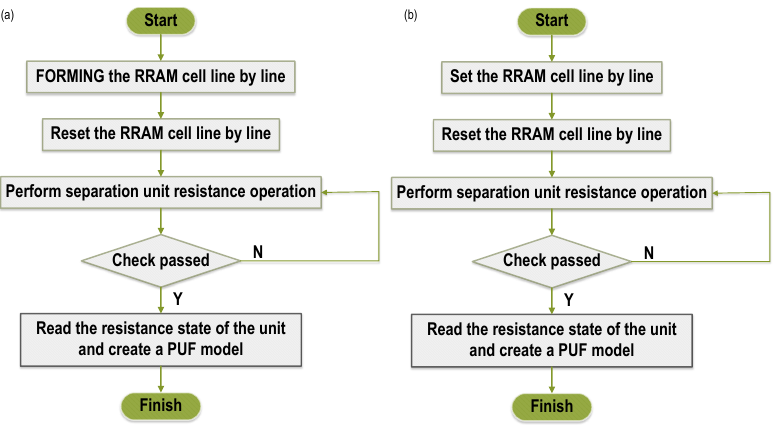
Figure 3. ( a ) RRAM PUF configuration process. ( b ) RRAM PUF reconfiguration